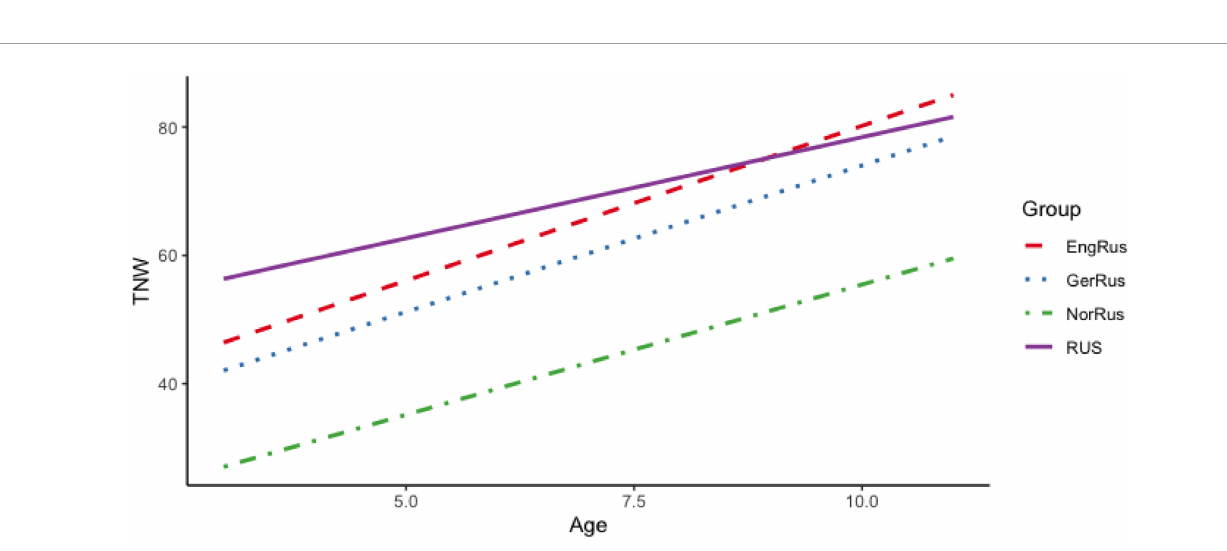
FIGURE2 Total number of words (TNW) per narrative in Russian heritage language (RHL) as a function of age and country.